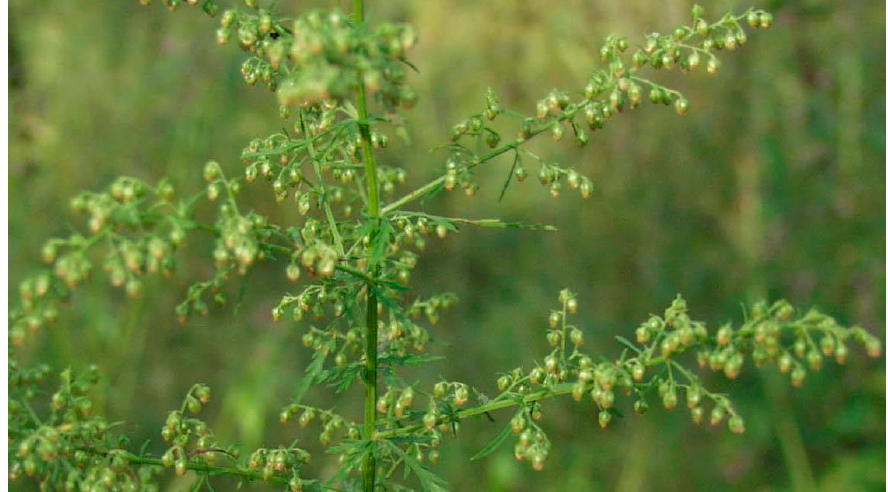
Figure 11. Artemisia annua. (http://www.plantsoftheworldonline.org/taxon/urn:lsid:ipni.org: names:304416-2, accessed on 1 April